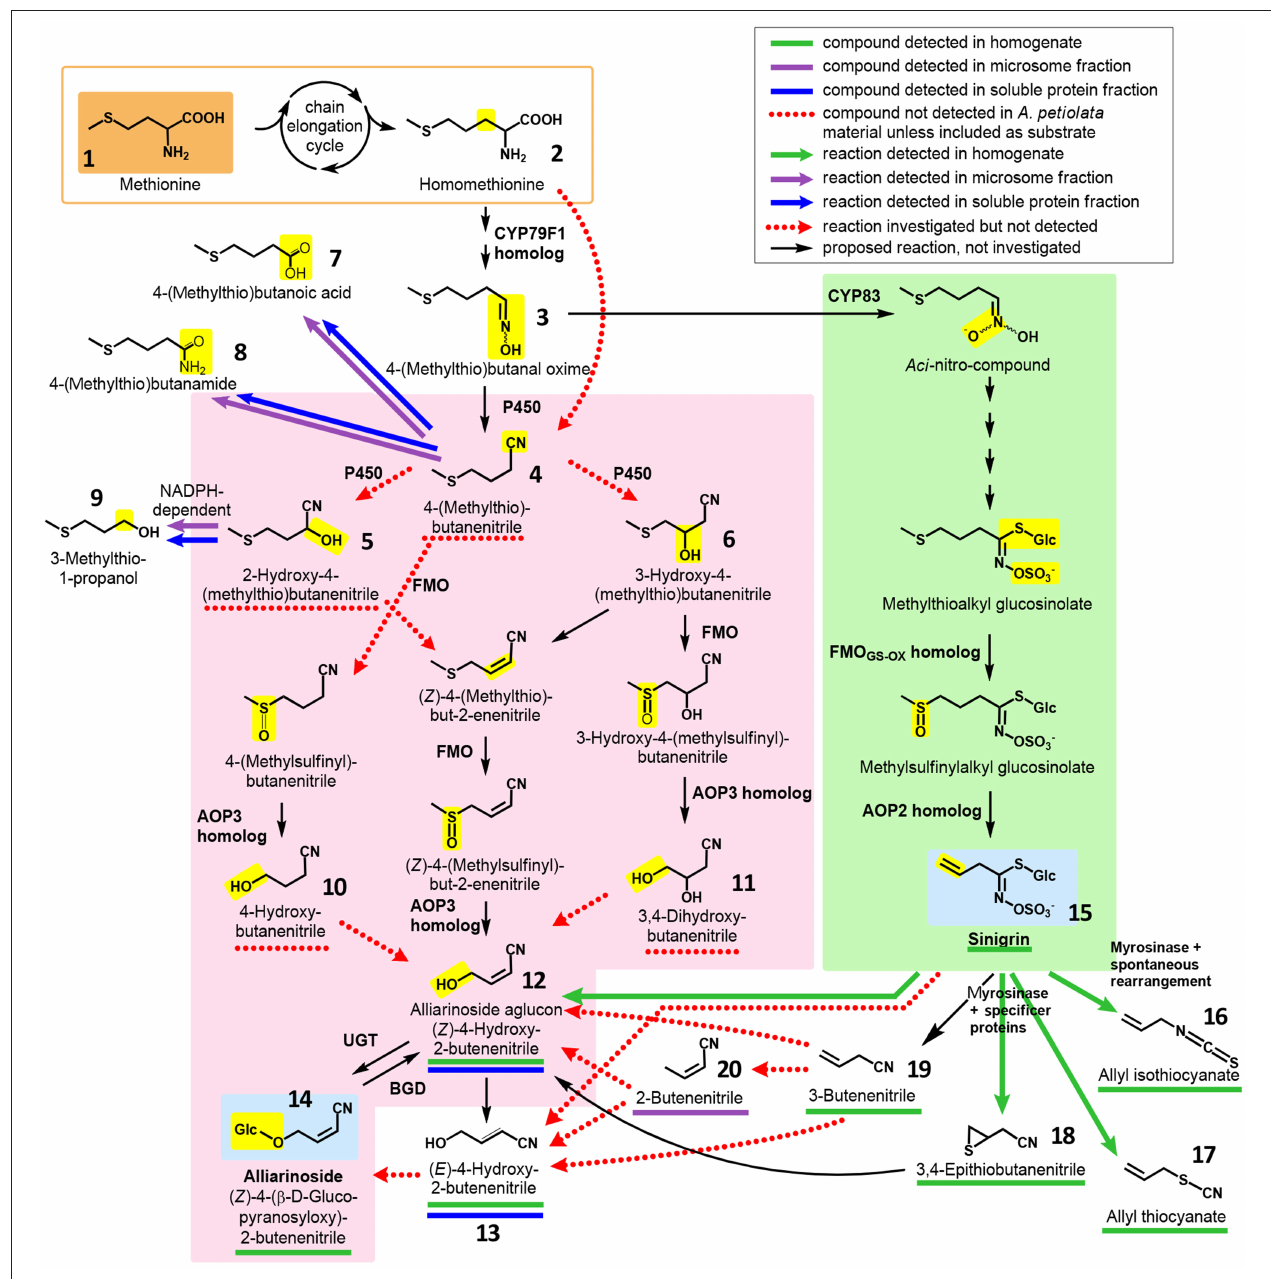
FIGURE 2 | Overview of hypothesized pathways and confirmed enzyme-catalyzed reactions in A. petiolata in relation to the biosynthesis of alliarinoside. We previously suggested that alliarinoside (14) is biosynthesized from methionine (1) via a pathway (pink box) bifurcating from the sinigrin (15) pathway (green box) at the level of the homomethionine-derived oxime (3). In the present study, methionine (orange box) was confirmed as the amino acid precursor of alliarinoside. However, investigations of metabolites and enzyme activities in A. petiolata did not support the subsequent steps in the proposed pathway (pink box). Considering the structural resemblance of the aliphatic side chain of sinigrin and alliarinoside, we explored the alternative hypothesis that alliarinoside is biosynthesized via sinigrin-degradation. The alliarinoside aglucon, (Z)-4-hydroxy-2-butenenitrile (12), was confirmed to be sinigrin-derived. Further details of alliarinoside biosynthesis from sinigrin remain to be elucidated, but several options were tested. The box in the upper right corner explains color notations of documented presence of metabolites and enzyme-catalyzed conversions. Moieties resulting from the indicated enzymatic conversion are shown on a yellow background. Only compounds mentioned in the main text are numbered. CYP, cytochrome P450; AOP, antioxidant protein, in this case 2-oxoglutarate–dependent dioxygenase; FMO, flavin monooxygenase; UGT, UDP-glucosyl transferase; BGD, β -glucosidase.